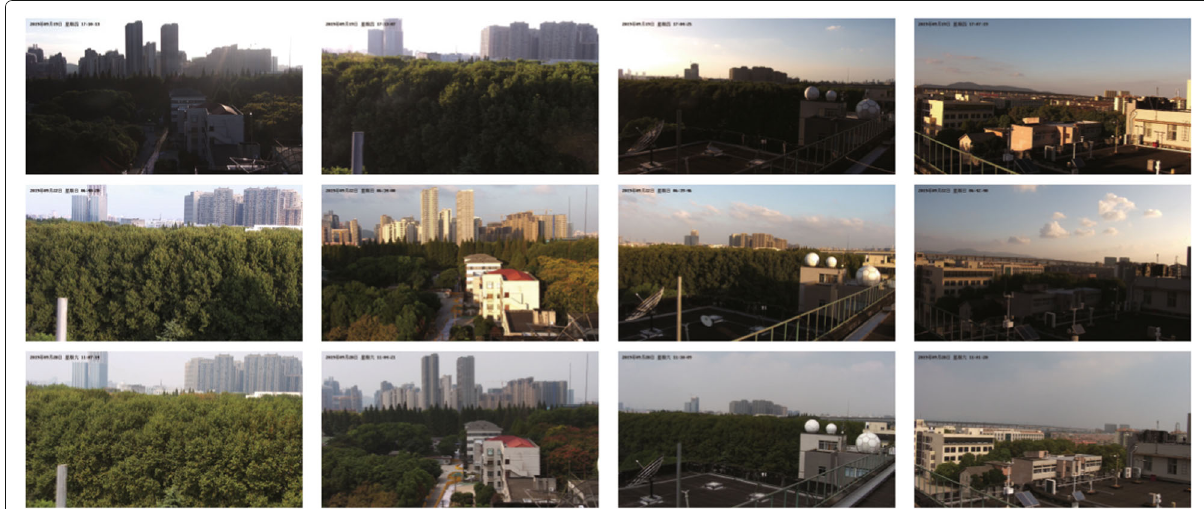
Fig. 6 Some images in RMID. Every line of images are captured at the same location and time with different views